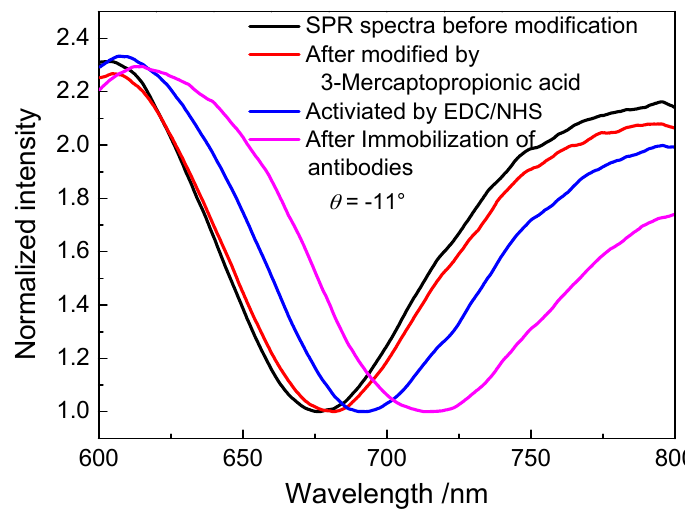
Figure 4. SPR spectra measured at θ = − 11 ◦ with the dried NPG film before the monolayer formation (black), after the monolayer formation (red), after activation of carboxyl groups (blue), and after antibody immobilization (pink).